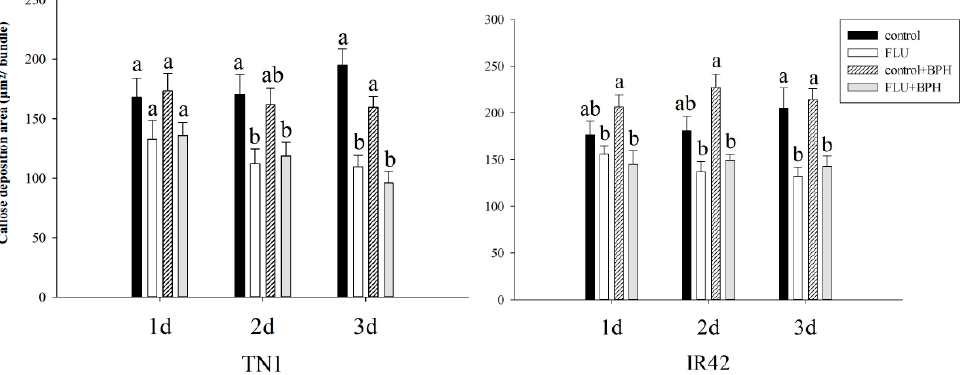
Figure 6. Changes of callose deposition area of TN1 and IR42 rice cultivars after 15 µ mol/L FLU treatment and BPH feeding. Different letters in the bars showed the means differed significantly under the same rice cultivar and the same BPH feeding days at the p < 0.05 level.